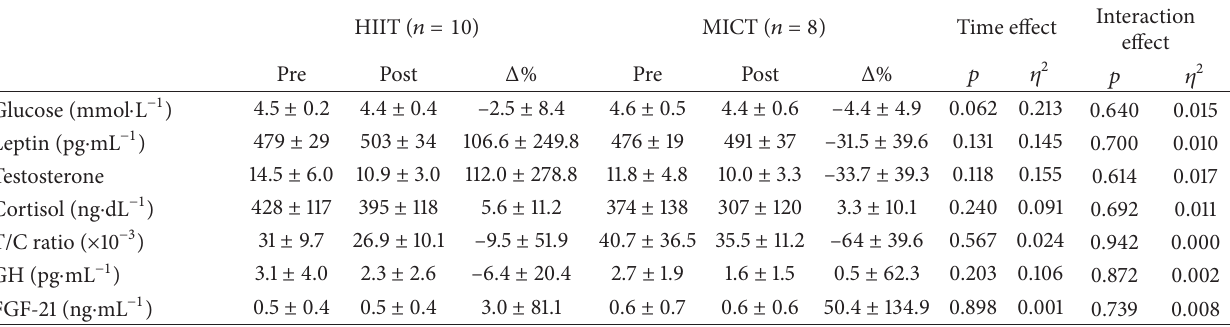
Table 2: Effect of training intervention on blood parameters.